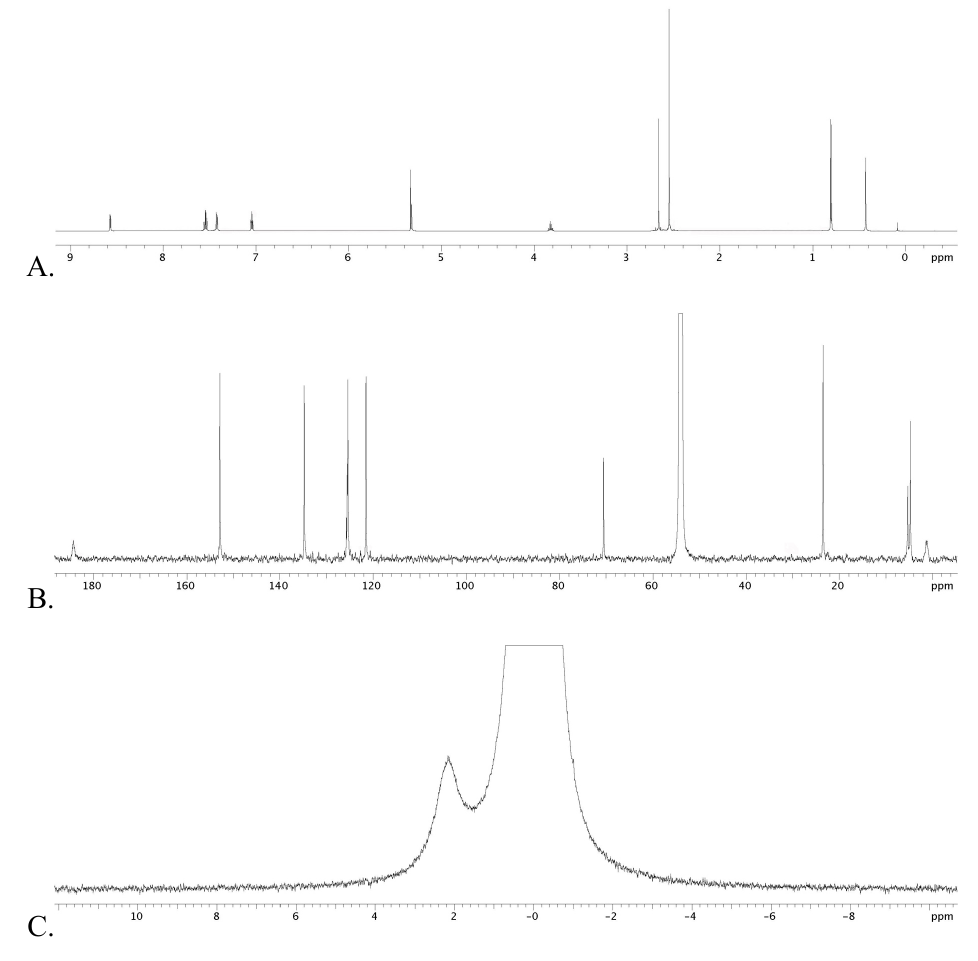
Figure 3. Graphical spectra for 14 . A, B and C are 1 H, 13 C and 11 B NMR spectral data, respectively. The bigger peak in 11 B spectrum corresponds to a BF